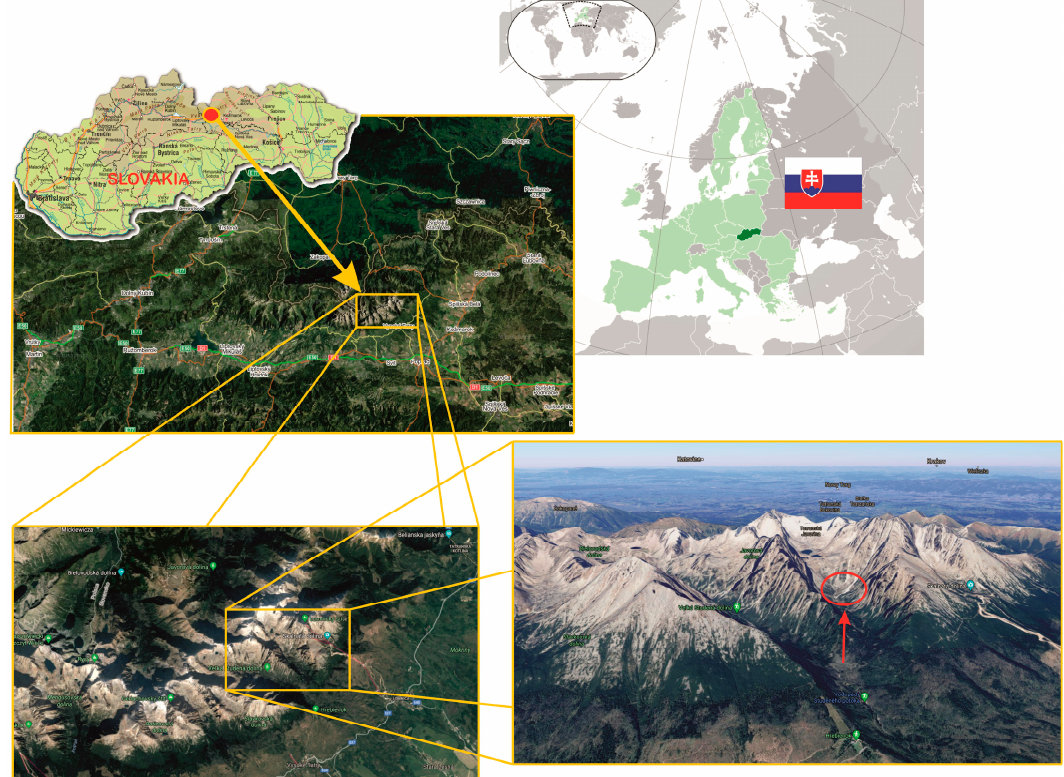
Figure 1. Location of the Small Cold Valley in the High Tatras, Slovakia.